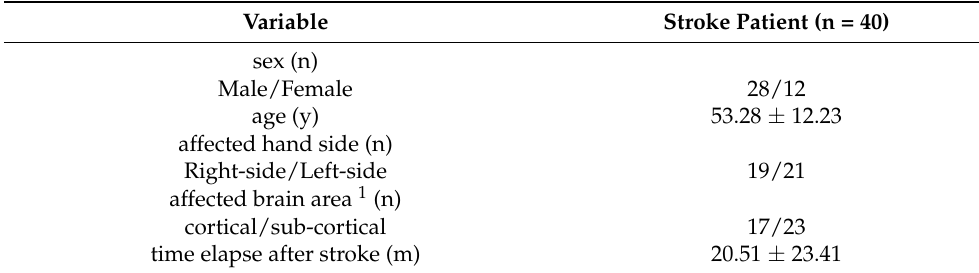
Table 1. The demographic and clinical characteristics of the stroke